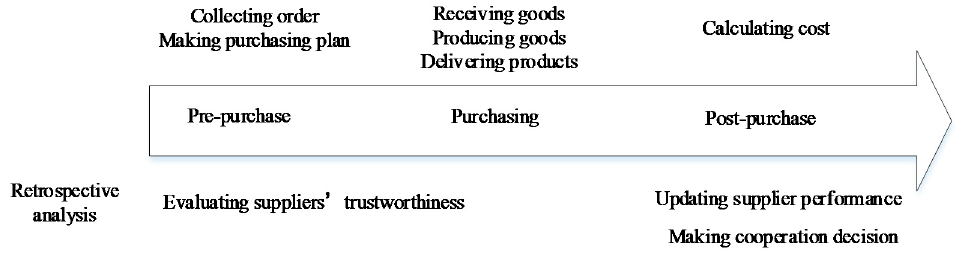
Figure 3. Identifying events in supply chain process using the steer wheel method.